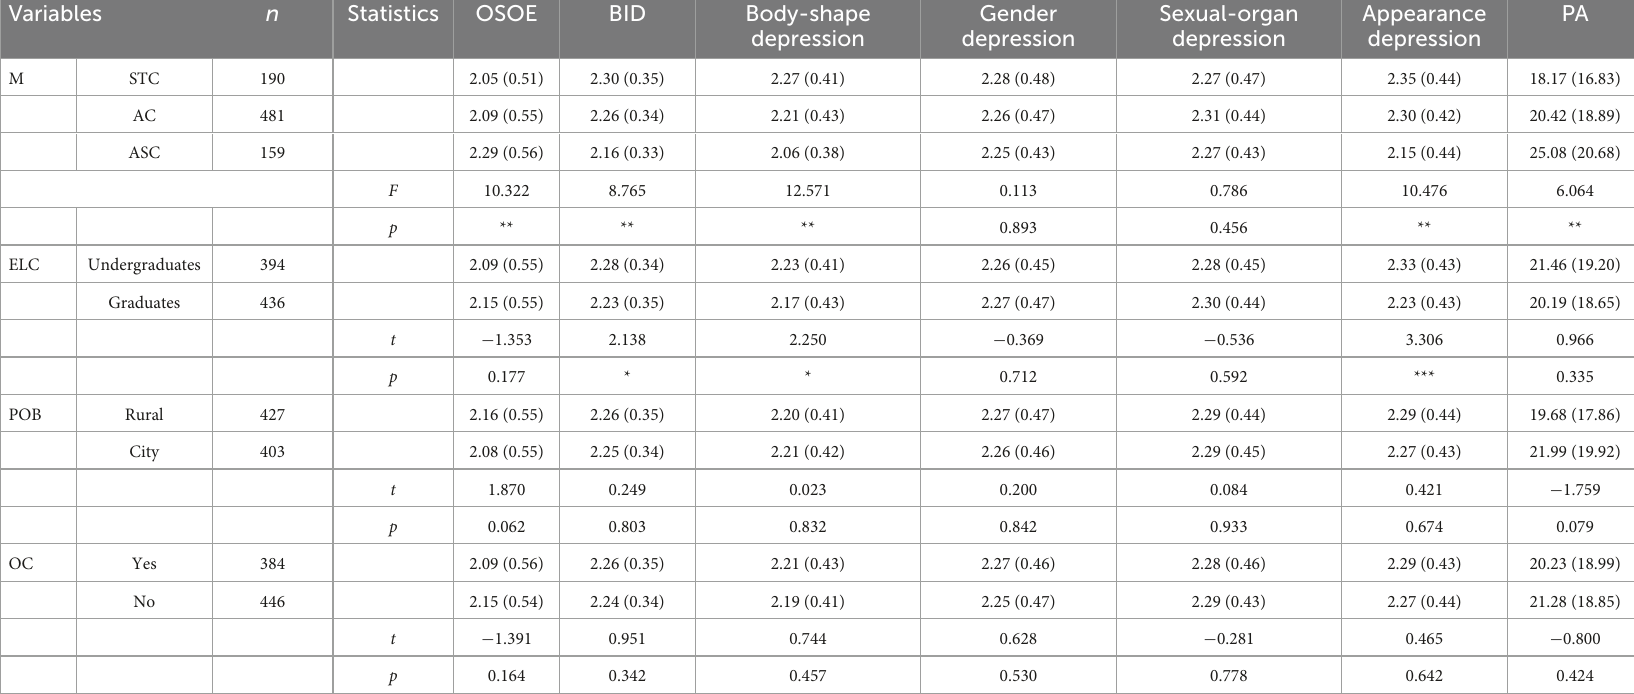
TABLE 1 Demographic characteristics of the